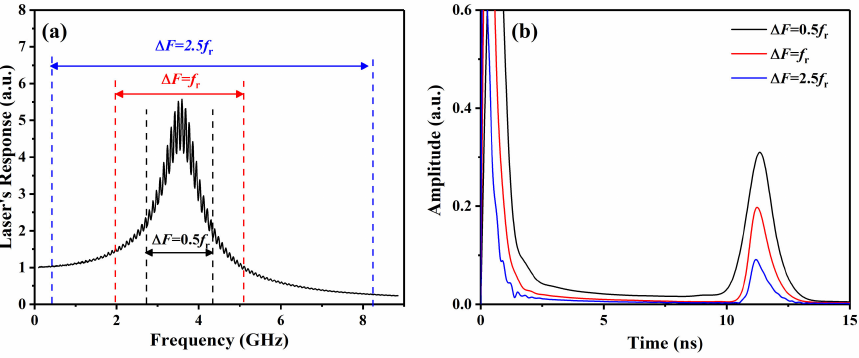
Figure 7. ( a ) Modulation response curve and ( b ) corresponding IFT curve under ∆ F = 0.5 f r and 2.5 f r .